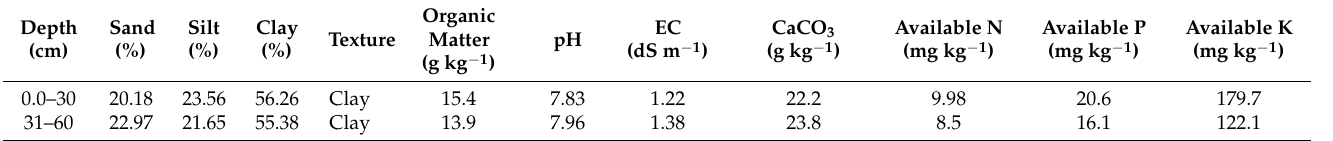
Table 9. Soil physical and chemical analyses of the experimental